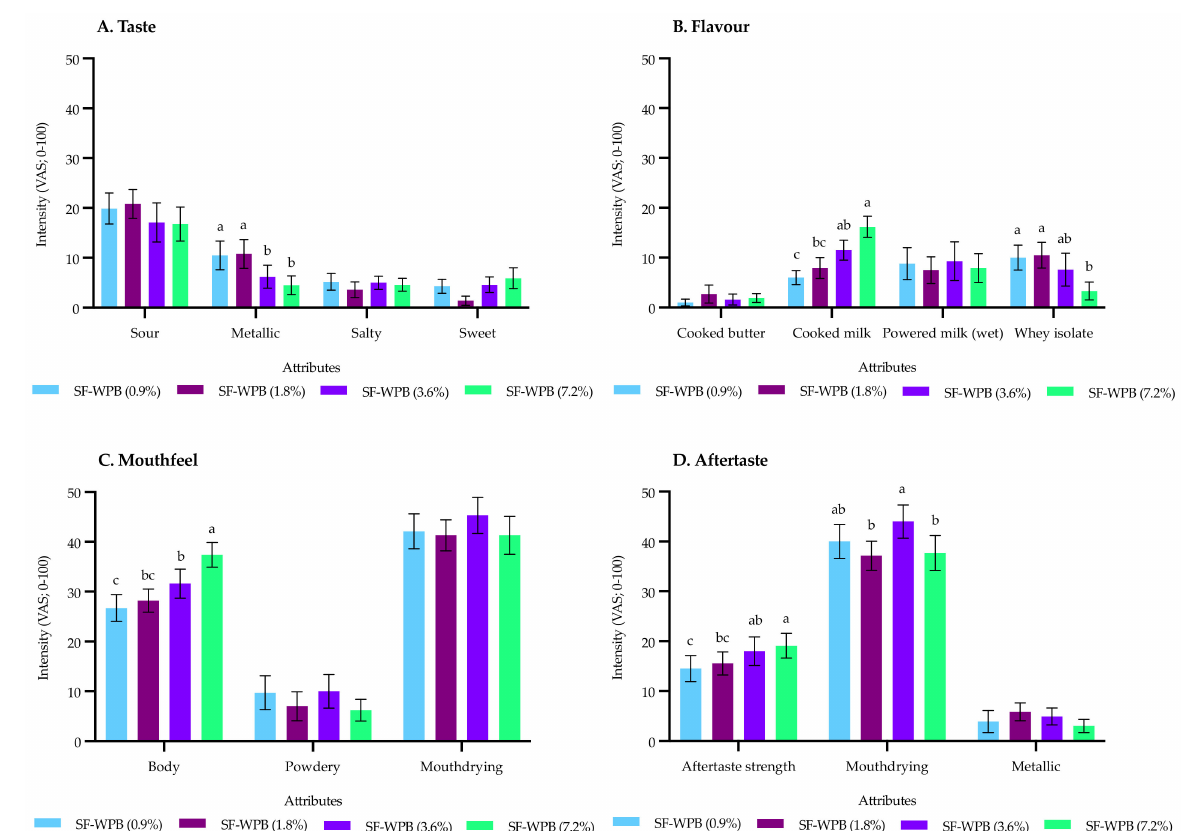
Data represents means of two replicates ± standard error from trained sensory panel ( n = 10) measured on visual analogue scales (VAS; 0–100). Differing small letters represent sample significance from multiple comparisons and brackets after sample name denote specific lactose content expressed as % w / v . All attributes are fully defined in Table 3.